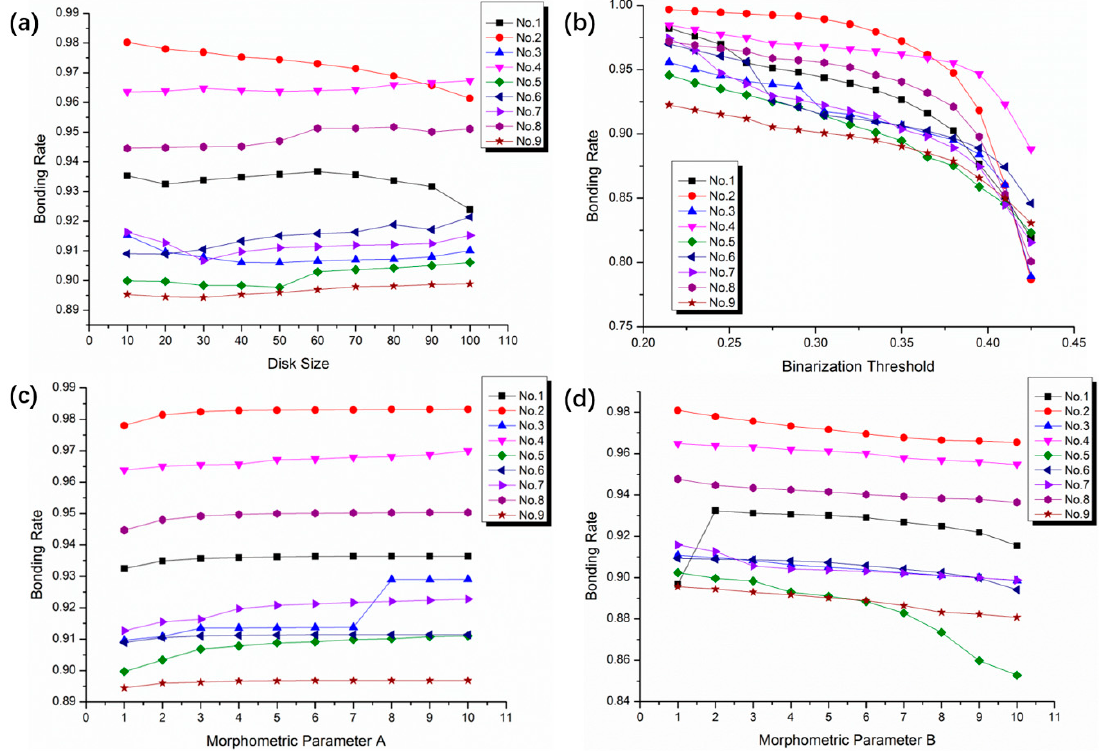
Figure 7. The results after changing the different parameters. ( a ) The bonding rates at different disk size. ( b ) The bonding rates at different binarization threshold. ( c ) The bonding rates at different morphological parameter A. ( d ) The bonding rate at different morphological parameter B.